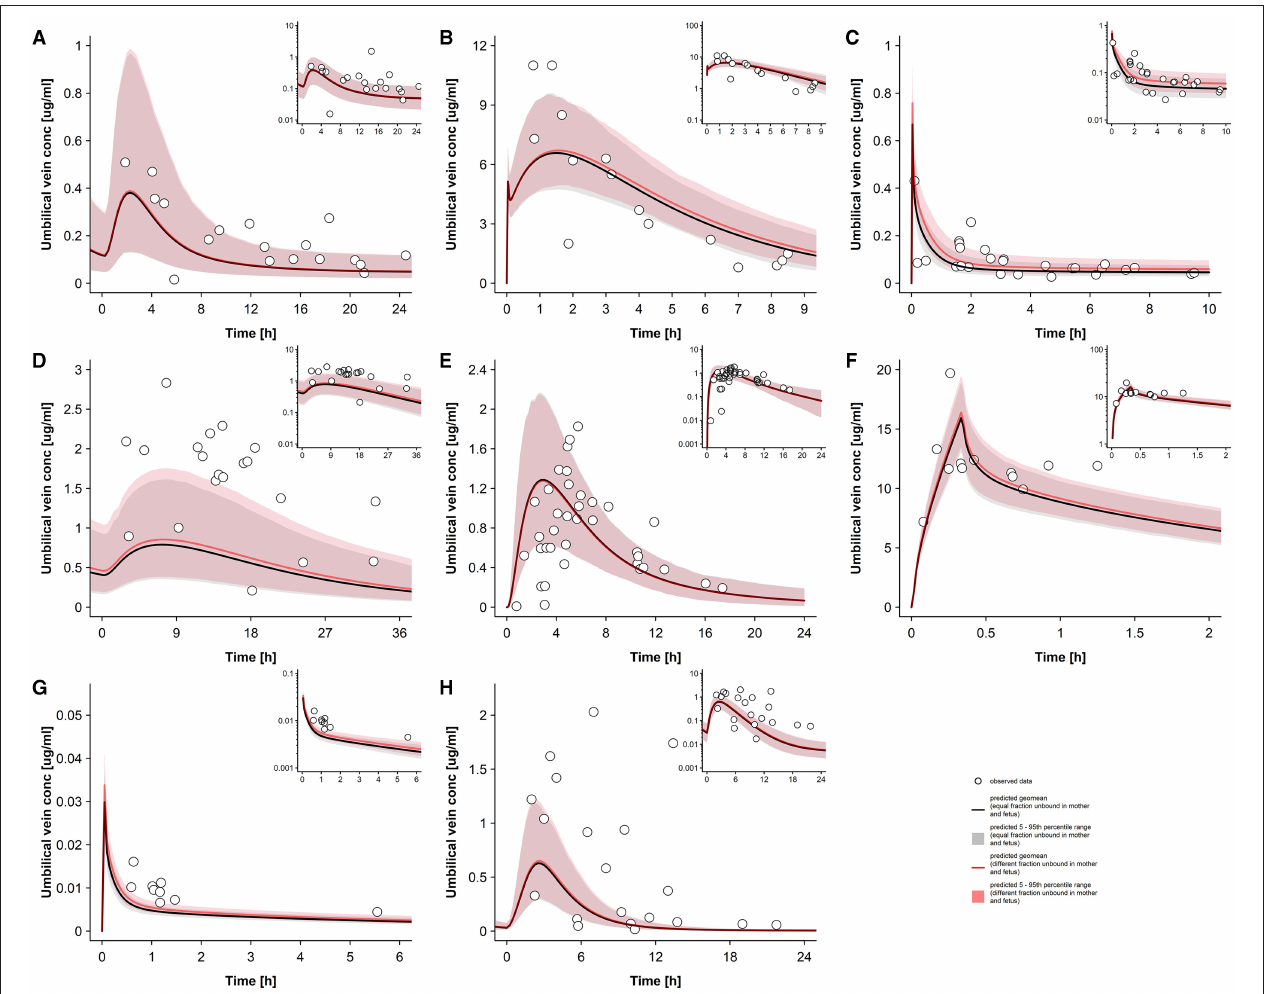
FIGURE 4 | Umbilical vein plasma concentration–time profiles observed and predicted at delivery. Concentration-time profiles in the umbilical vein plasma for acyclovir (A) , cefuroxime (B) , diazepam (C) , dolutegravir (D) , emtricitabine (E) , metronidazole (F) , ondansetron (G) , and raltegravir (H) at delivery in the third trimester. Semi-log scaled figures are shown as inset plot in the top-right corner of each panel. The time refers to the time after drug administration. Circles represent individual observed data; the solid line represents the predicted geomean and the shaded area the predicted 5th − 95th percentile range. Red shades denote to predictions with different maternal/fetal unbound drug fractions and black/gray colors predictions with equal maternal and fetal unbound drug fractions. Observed data for acyclovir, cefuroxime, diazepam, dolutegravir, emtricitabine, metronidazole, ondansetron, and raltegravir were taken from Liu et al. ( 18), Leung et al. (39), Hirt et al. (40), Philipson and Stiernstedt (41), De Leeuw et al. (42), Elkomy et al. (43), Visser and Hund (44), Moore and McBride (45), Ridd et al. (46), and Mandelli et al. (47), respectively. conc,